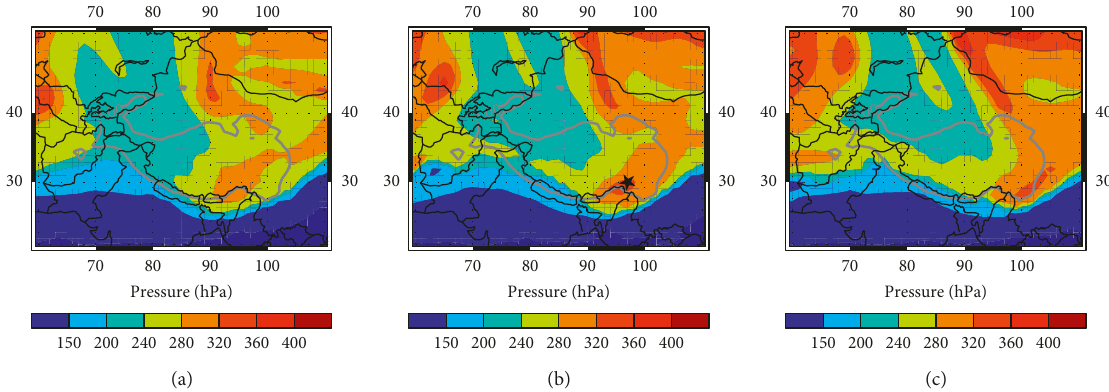
Figure 8: Pressure on the 2 pvu tropopause surface (color shadings; hPa) at 12:00 UTC 29 December 2018 (a), 18:00 UTC 29 December 2018 (b), and 00:00 UTC 30 December 2018 (c). Gray contours indicate the location of the TP (3km elevation). The black pentagram indicates the departure point of the trajectory shown in Figure 12.